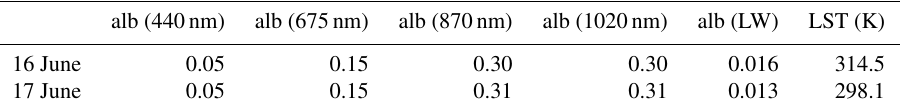
Table 3. Surface albedo, alb( λ ), values provided by AERONET for the SW spectral range and by CERES for the LW. Land-surface temper- ature (LST) on 16 June was obtained from MODIS, whereas on 17 June it was estimated from the meteorological station at the Granada site. These surface parameters are common to all parameterizations. alb (440nm) alb